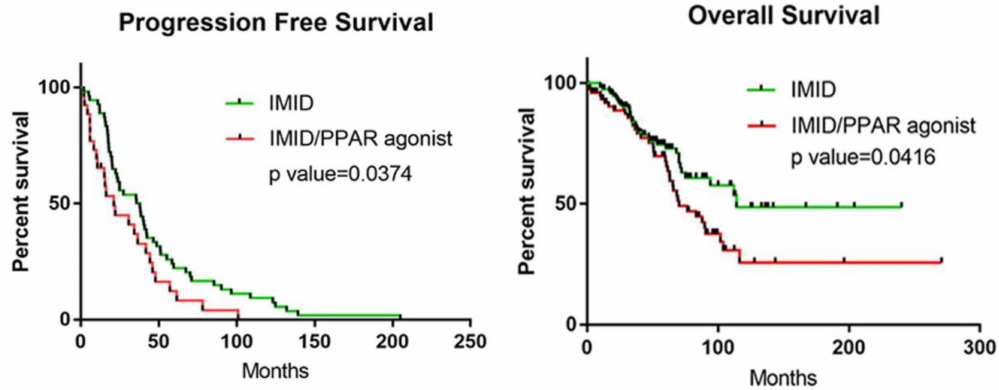
Figure 5. Coadministration of PPAR agonists with IMiDs is associated with worse progression-free survival and overall survival. Left panel: progression-free survival. Right panel: overall